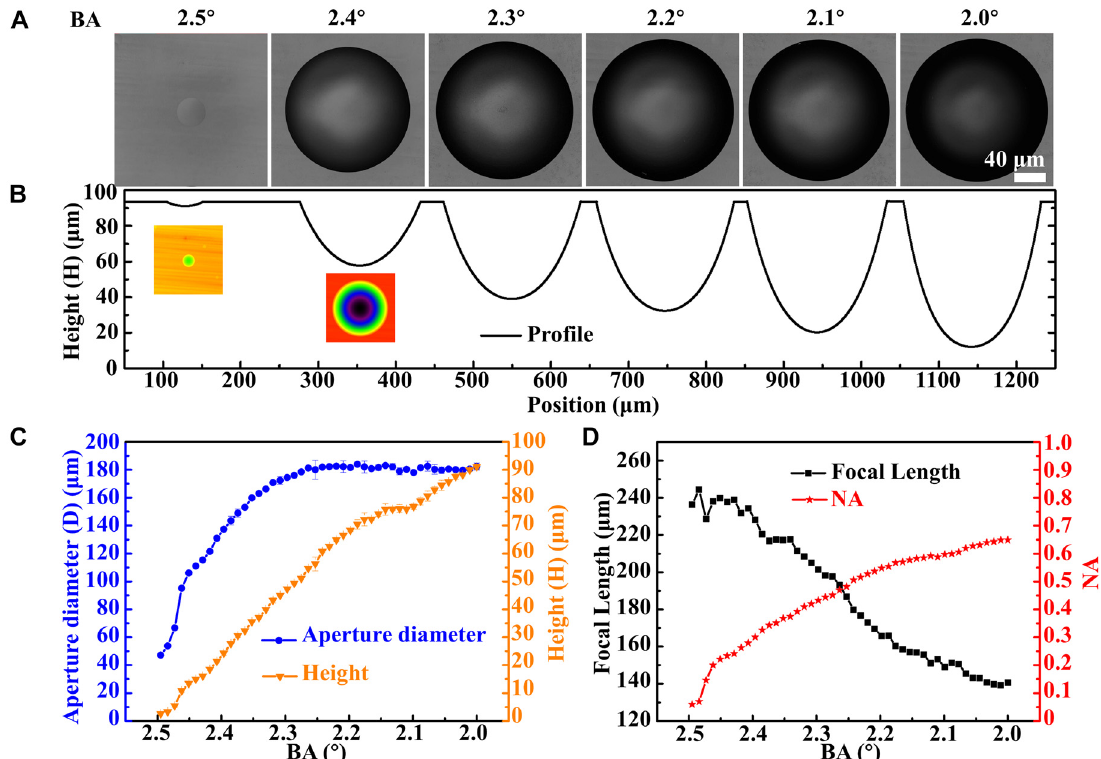
Figure 2: Microlenses defined by the BLBs with a variety of BAs. (A) LSCM top view of the microlenses after etchingfor 20 h. (B) Corresponding cross-sectionpro fi les of the microlenses in (A) and the pseudo- color images corresponding to 2.5 ° and 2.4 ° (inset images). (C) Aperture diameters and heights of the microlenses etched after exposure with different BAs. (D) Relationship among BAs, focal lengths (absolute value), and NAs of the